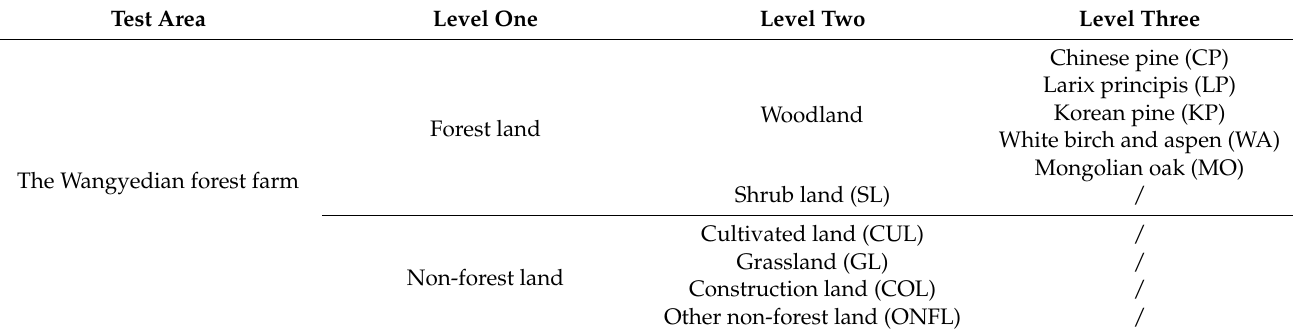
Table 1. Classification system of the Wangyedian study areas.